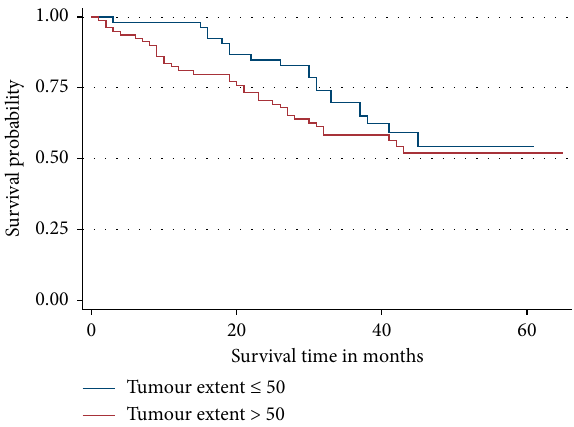
Figure 7: Overall survival by tumour extent (TE). Patients with high TE were dying more than those with low TE.